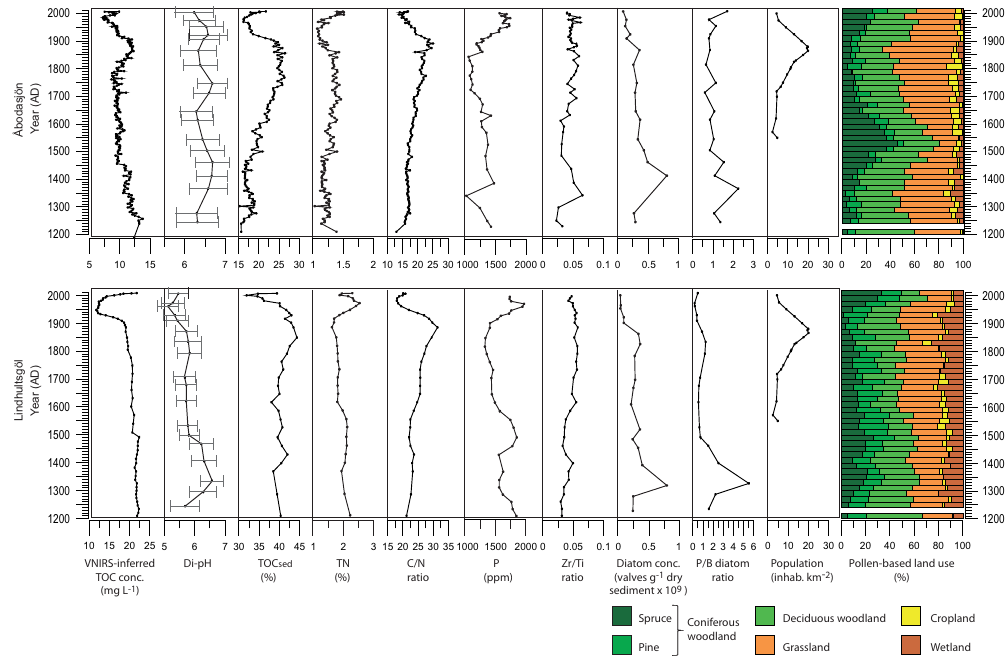
Figure 2. Records of VNIRS-inferred lake-water total organic carbon (TOC) concentration, diatom-inferred pH (Di-pH) (horizontal error bars represent ± 1SD), sediment total organic carbon (TOC sed ) and total nitrogen (TN) content, atomic carbon:nitrogen (C / N) ratio, elemental phosphorus (P) content, elemental zirconium:titanium (Zr / Ti) ratio, diatom valve concentration, diatom planctonic:benthic (P / B) ratio, documented population density, and pollen-based land use plotted against age from Åbodasjön (upper panel) and Lindhultsgöl (lower panel).